Question: What type of chart is this?
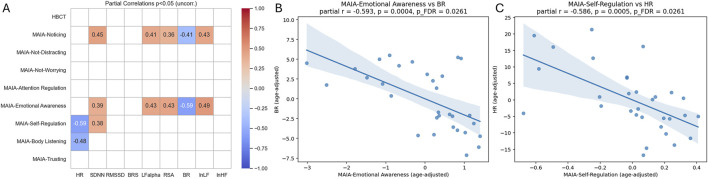
Answer: heatmap